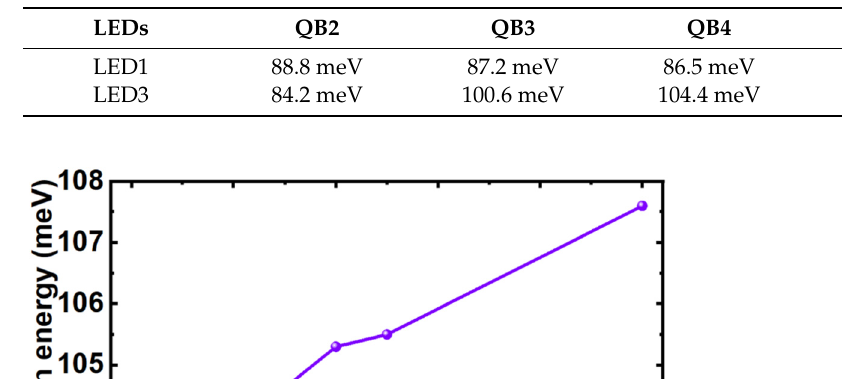
Table 5. Comparison of qV1 and qV2 values of LED 1 and LED 3.